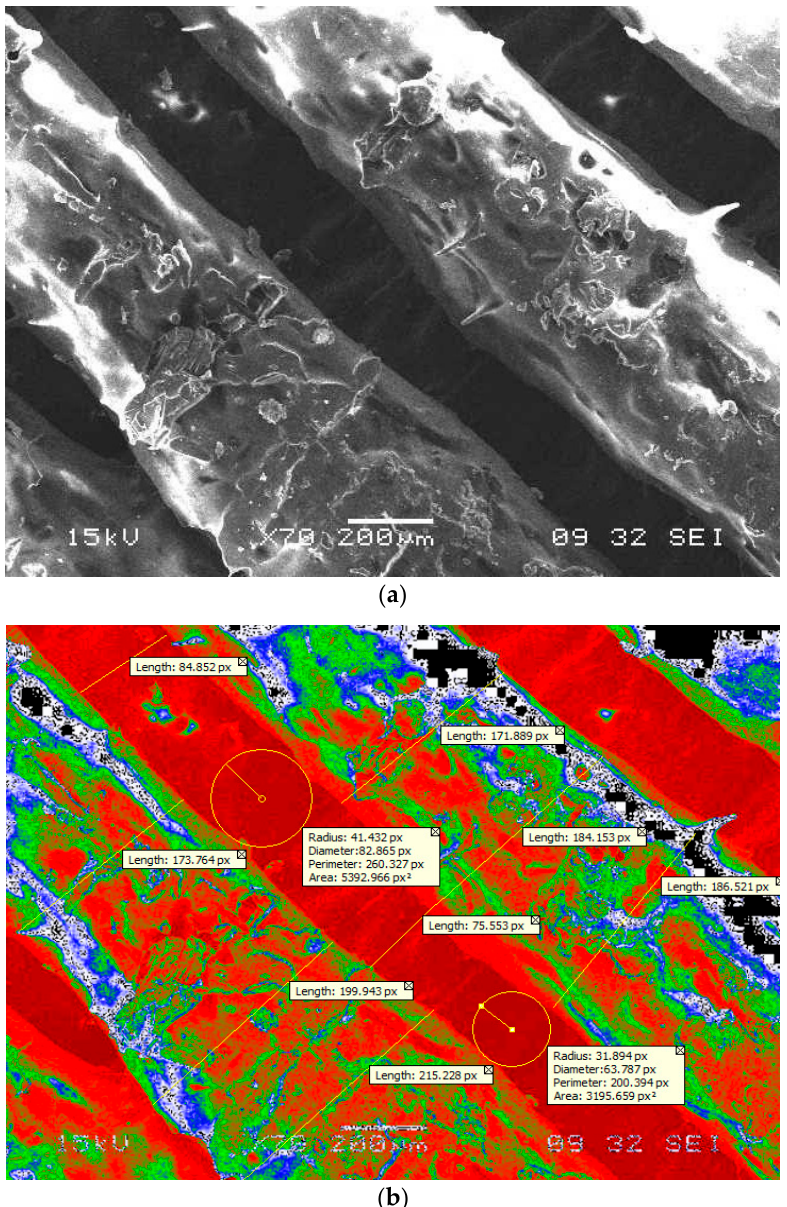
Figure 16. ( a ) SEM micrograph at 200 µm, ( b ) assessment of fibers at 45° by image segments analysis.